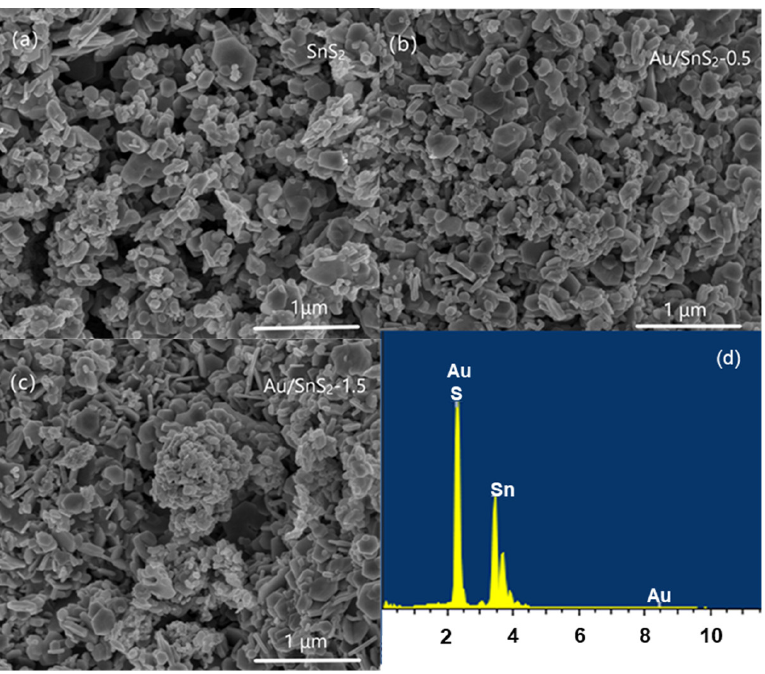
Figure 4. SEM images of ( a ) SnS 2 , ( b ) Au/SnS 2 -0.5, ( c ) Au/SnS 2 -1.5, and ( d ) EDS elemental estimation of the Au/SnS2-0.5 sample.